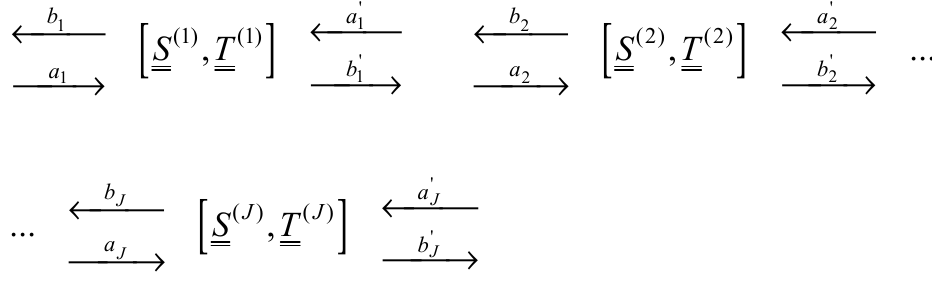
Figure 2. Block diagram of a multi-layer antenna. Both types of matrices lead to a global description of the operation of the entire antenna The matrix S ( j ) or T ( j ) represents the planar discrete element of the antenna in the form structure [8]. Global transmission matrix T of a flat metallized grid, a boundary between two dielectric media or a dielectric layer [7]. It was assumed that a